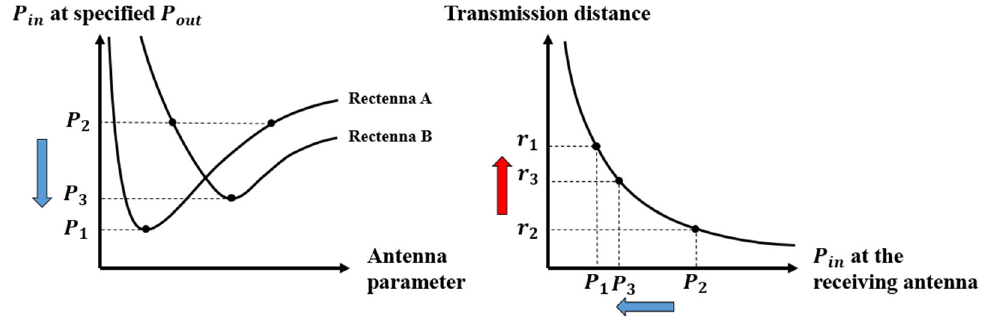
Figure 2. Antenna parameters vs. P in and P in vs. transmission distance.